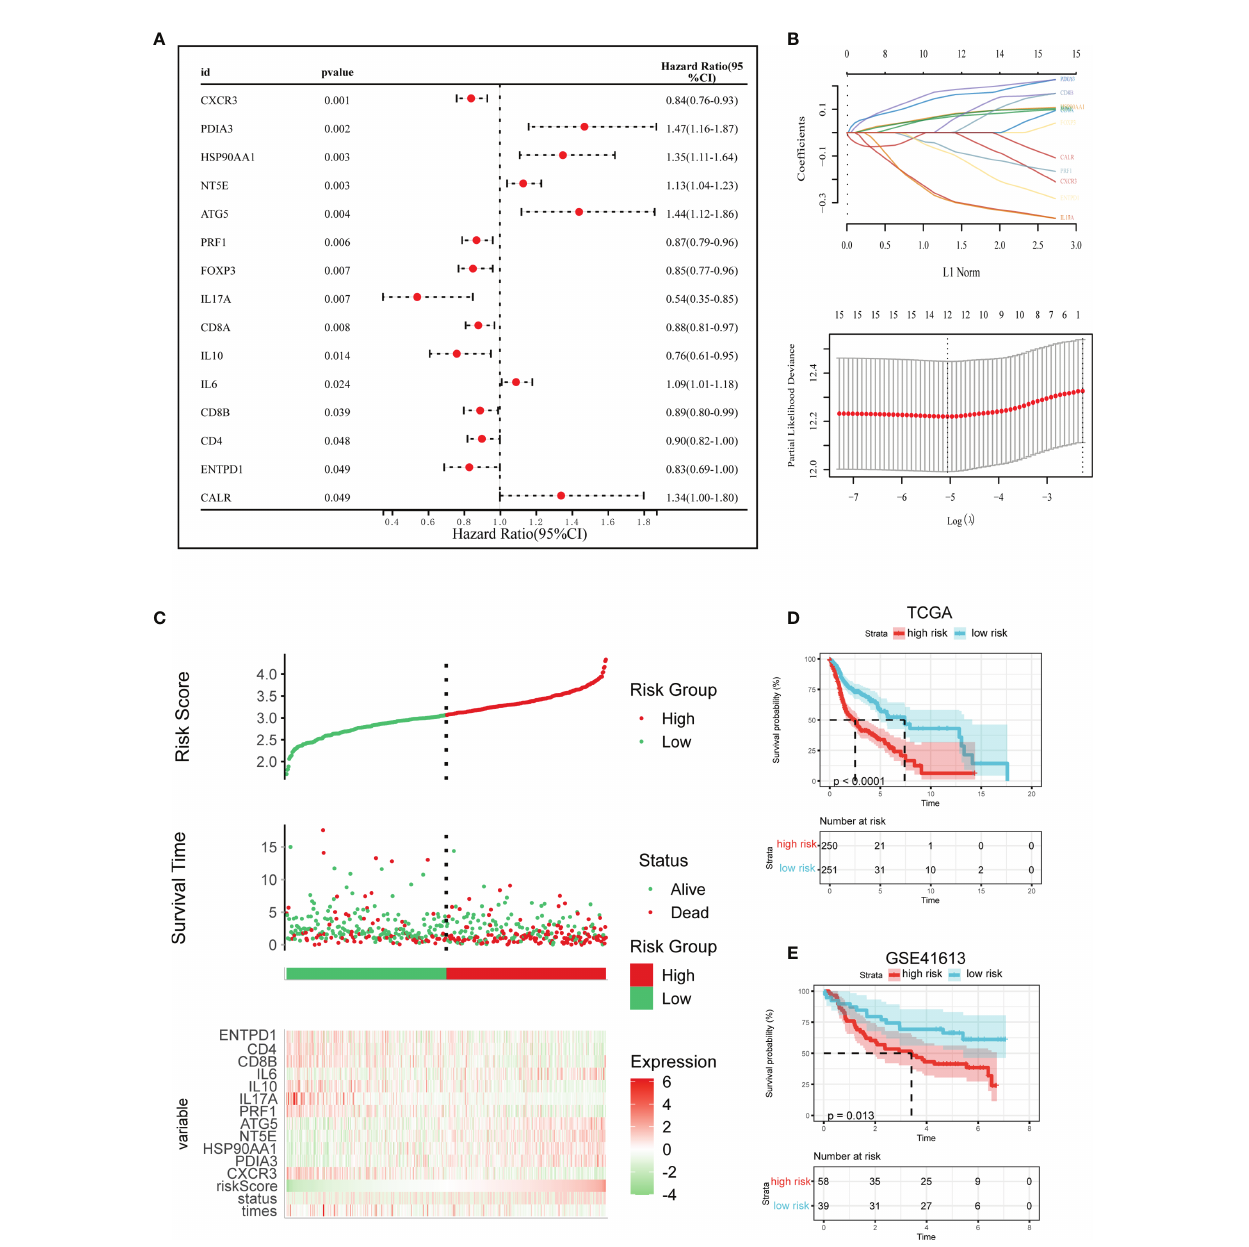
FIGURE 5 | Construction and validation of the ICD risk signature. (A) Univariate Cox analysis evaluates the prognostic value of the ICD genes in terms of OS; (B) Lasso Cox analysis identi fi ed 12 genes most associated with OS in TCGA dataset; (C) Risk scores distribution, survival status of each patient, and heatmaps of prognostic 12- gene signature in TCGA database; (D, E) Kaplan – Meier analyses demonstrate the prognostic signi fi cance of the risk model in TCGA and GSE41613